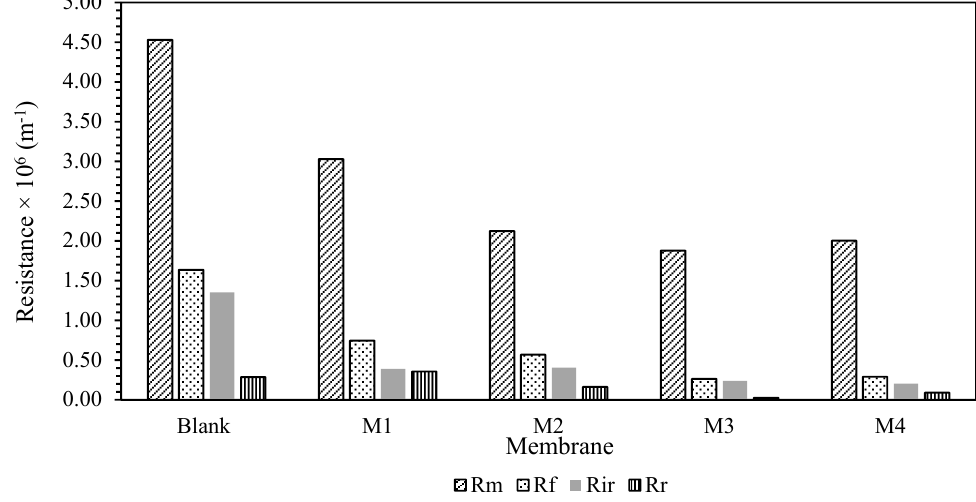
Figure 6. Filtration resistance of the membrane.